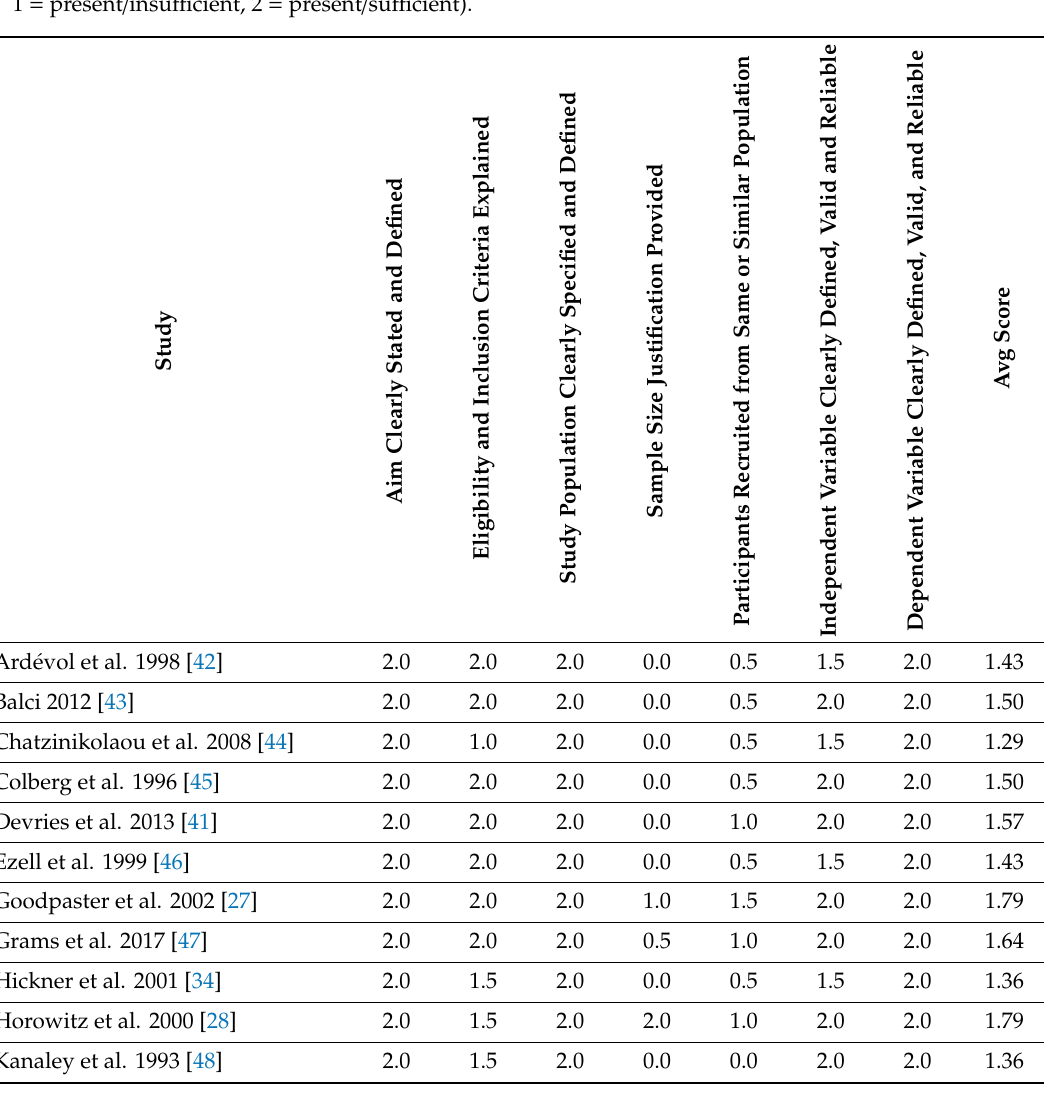
Table 3. Scores for general methodological quality for the 24 included studies (0 = absent / insu ffi cient, 1 = present / insu ffi cient, 2 = present / su ffi